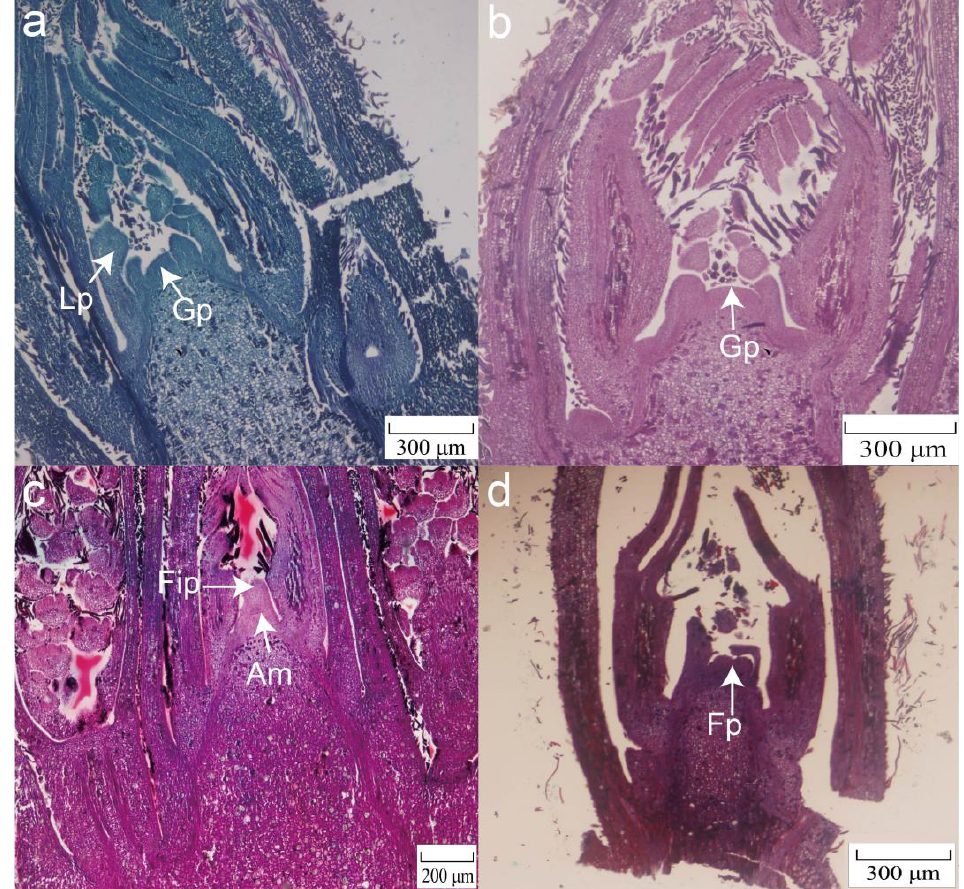
Figure 2. Morphological characteristics of pecan female flower bud differentiation. ( a ) The growing point (Gp) of the bud became smaller and pointed; the leaf primordium (Lp) began to differentiate in early May. ( b ) The flower buds gradually became flattened and sunken at the top growth point, and the flower buds entered the critical period of morphological differentiation, which lasted until the end of June (FD1). ( c ) From late June until mid-July, the growth point of the buds elongated upwards and gradually became rounded, forming a prominent spherical shape. The apical meristem (Am) and female inflorescence primordia (Fip) were observed during this period. ( d ) After the spherical protrusions were formed, the corresponding tips differentiated into the female flower primordia (Fp, FD2).